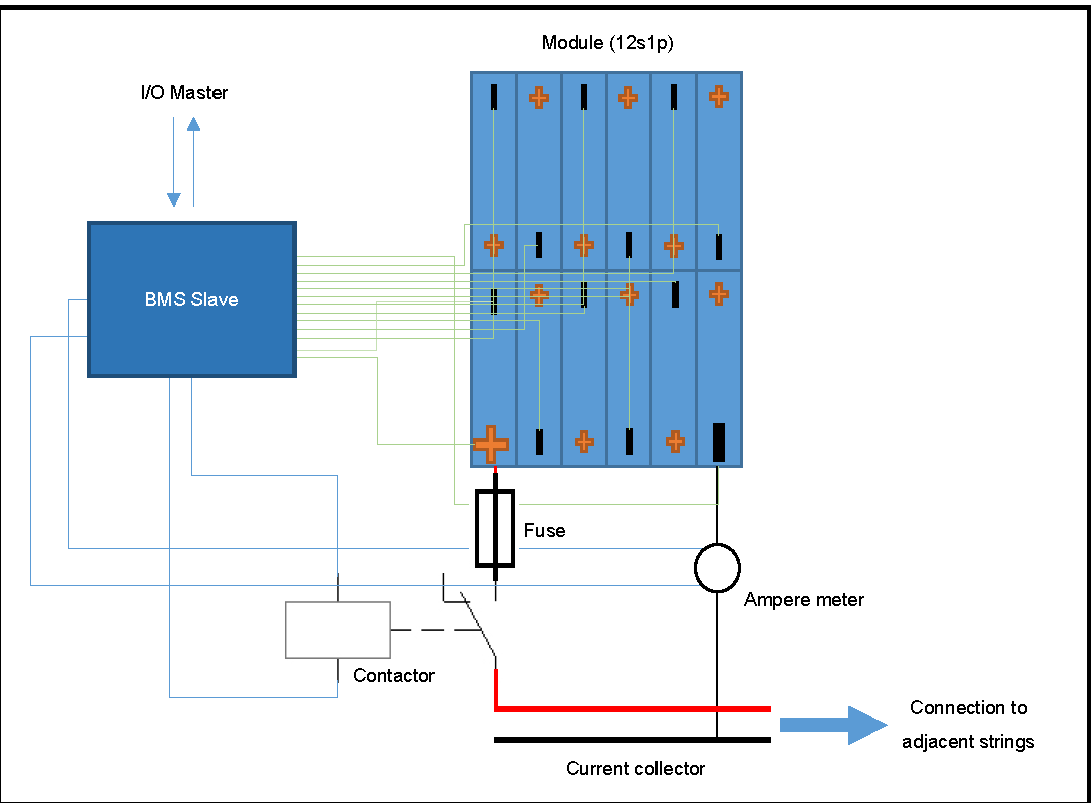
Figure A1. Basic module configuration of one individual string within the assembled battery storage.